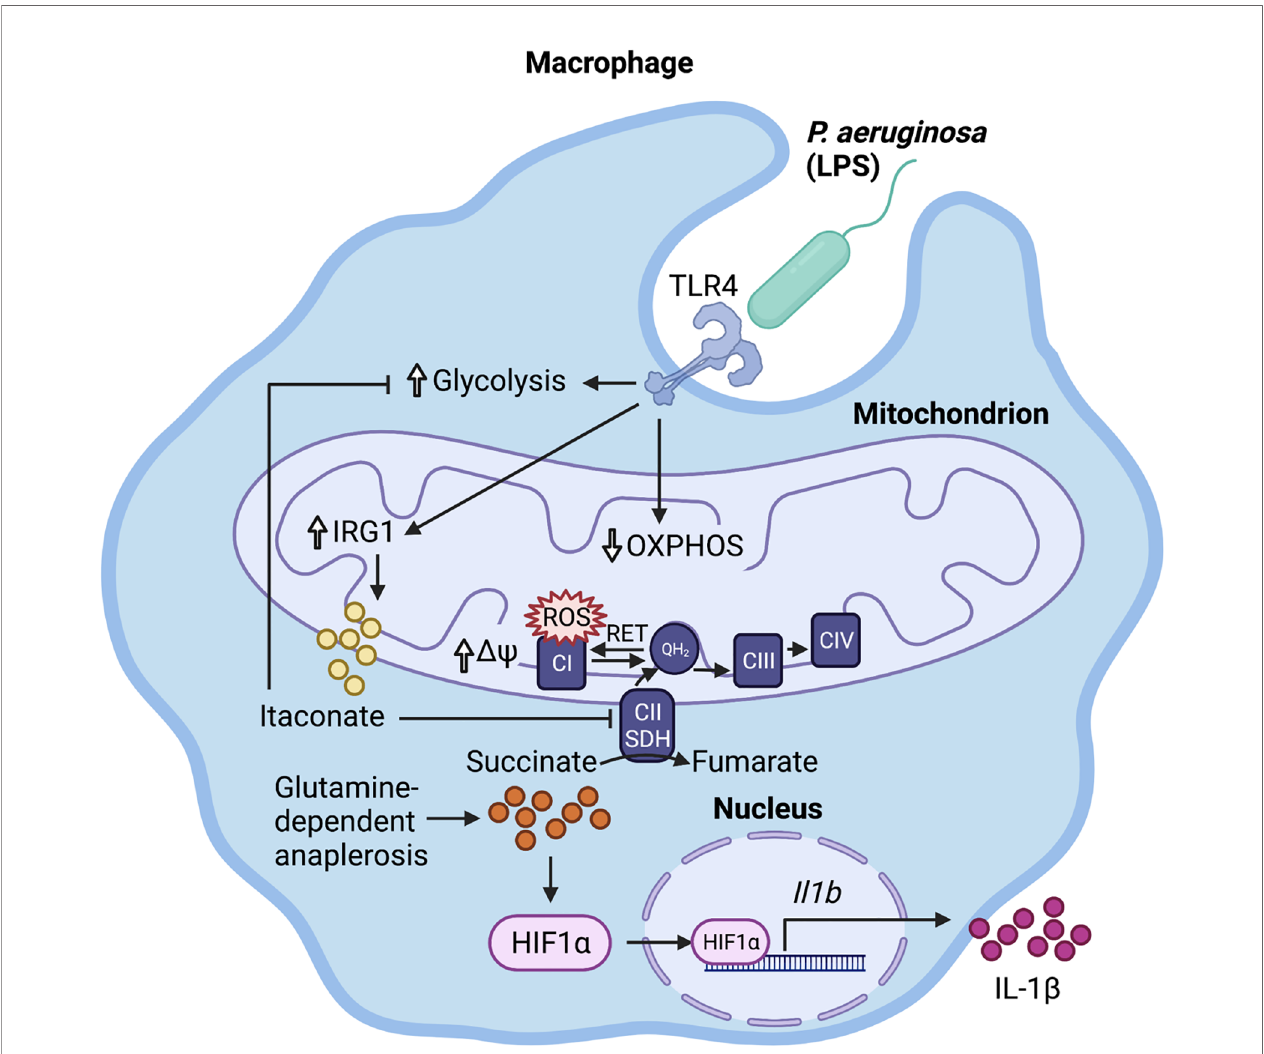
FIGURE 1 | Immunometabolic response to P. aeruginosa . LPS activates the infected macrophage, stimulating glycolysis and downregulating oxidative phosphorylation (OXPHOS). This promotes glutamine-dependent anaplerosis, which replenishes succinate for oxidation to fumarate by mitochondrial succinate dehydrogenase (SDH). The resulting increase in mitochondrial transmembrane potential ( Δ Y ) and over-reduction of the ubiquinone pool reverse electron fl ow to complex I, where they escape as reactive oxygen species (ROS). Both ROS and succinate stabilize HIF-1 a , which translocates to the nucleus and binds to its target promoter regions, increasing Il- 1 b transcription. The succinate-driven in fl ammation is regulated by the production of the anti-in fl ammatory metabolite